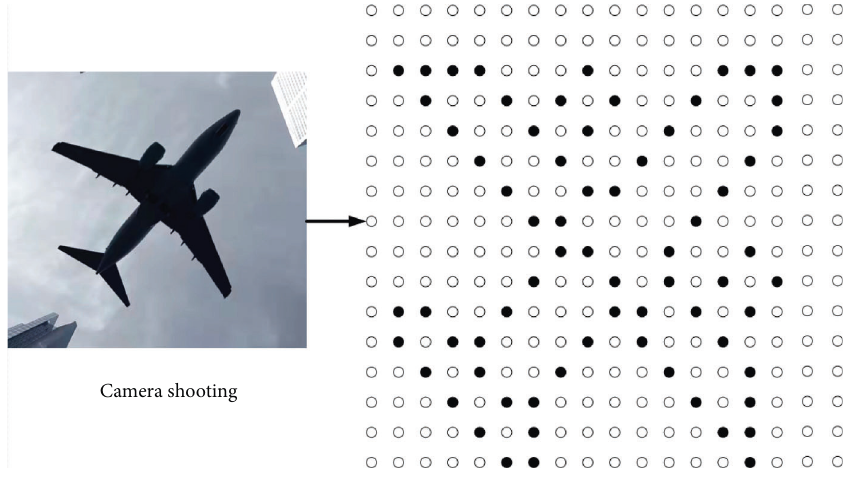
Figure 9: Schematic diagram of two-dimensional electrode array electrical